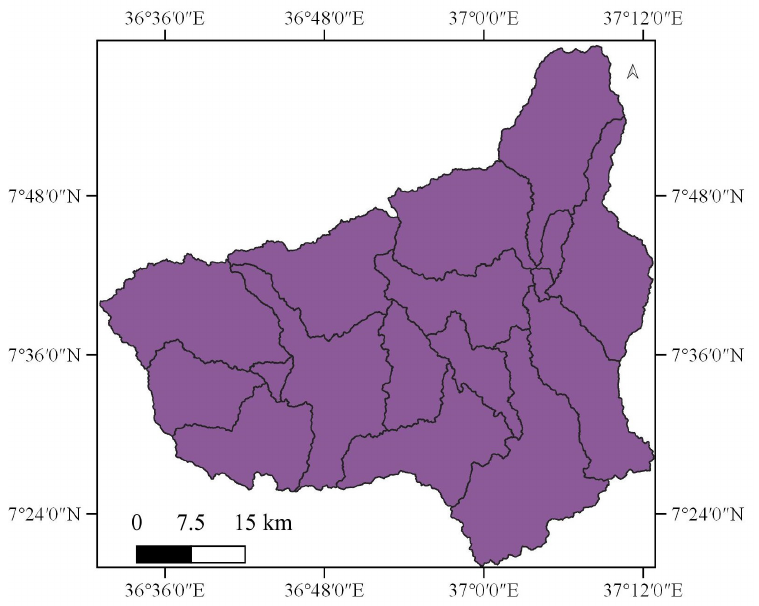
Figure 5. Gilgel Gibe 1 Watershed in the Omo-Gibe River